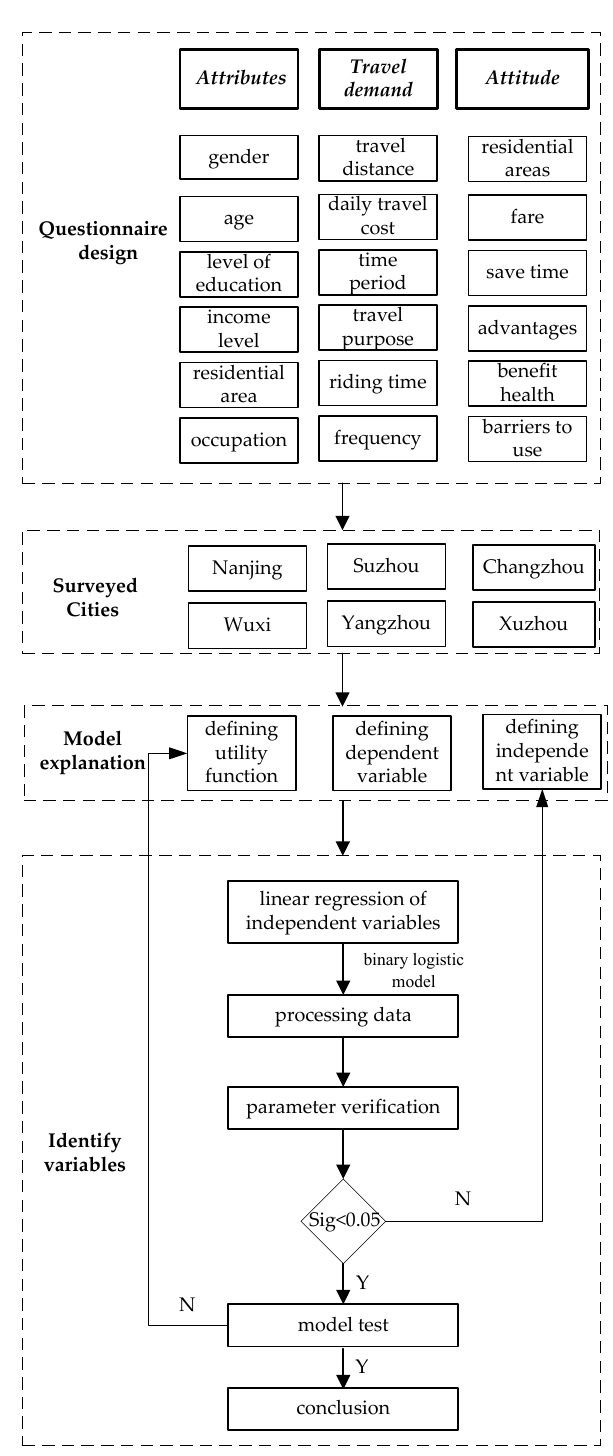
Figure 2. Research outline.